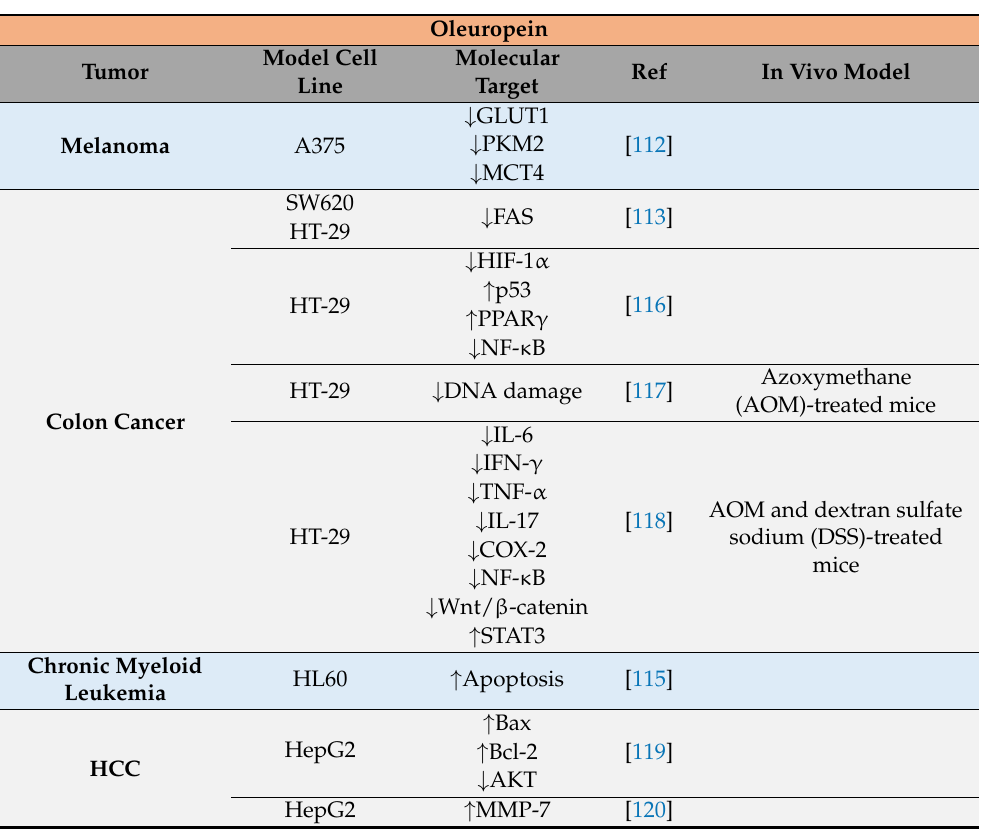
Table 3. Anti-cancer effects of Oleuropein and Ligstroside: in vitro and in vivo